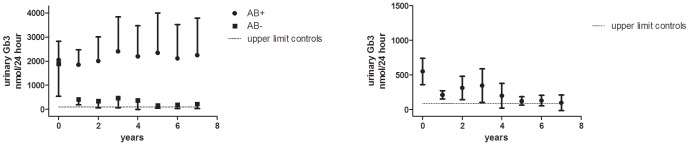
Urinary Gb3 in males and females.
A. Urinary Gb3 in classic Fabry males, treated for at least one year (AB+ group n = 11, AB− group n = 11). B. Urinary Gb3 in classic Fabry females treated for at least one year (n = 28), depicting mean and 95% confidence interval. The dotted line denotes upper limit of normal in healthy controls: 18–90 nmol/24 uur.